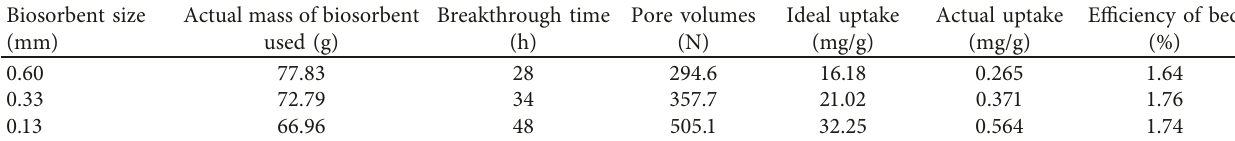
Table 2: Effect of biosorbent size.